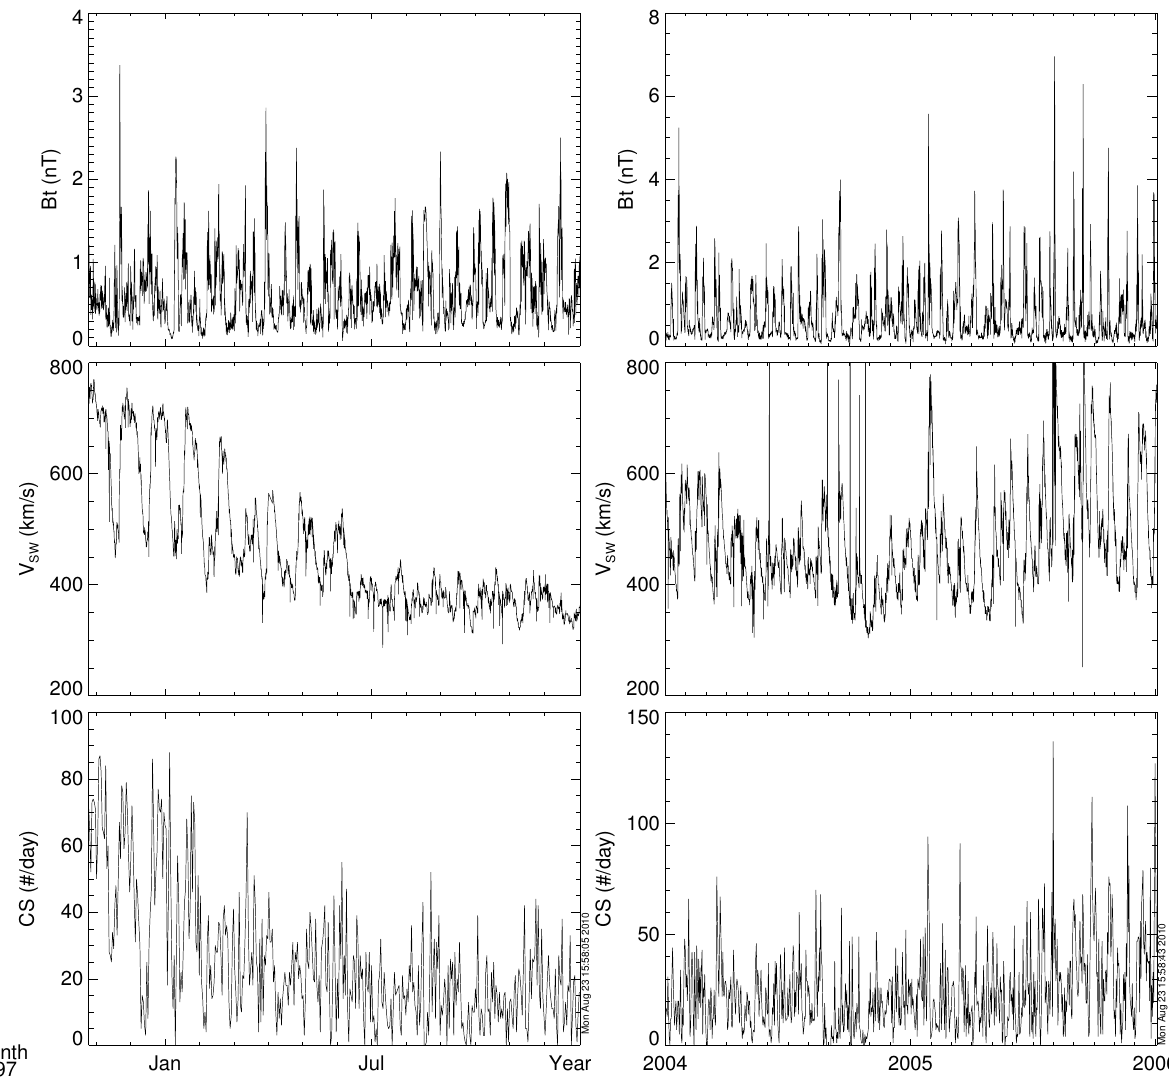
Fig. 5. B t , V SW , and current sheet density are plotted as functions of UT time. The time period in the left side is from 1996-300 to 1997-365. The time period in the right side is from 2004-1 to 2006-3. The current sheet density is calculated as the number of current sheet occurrences per